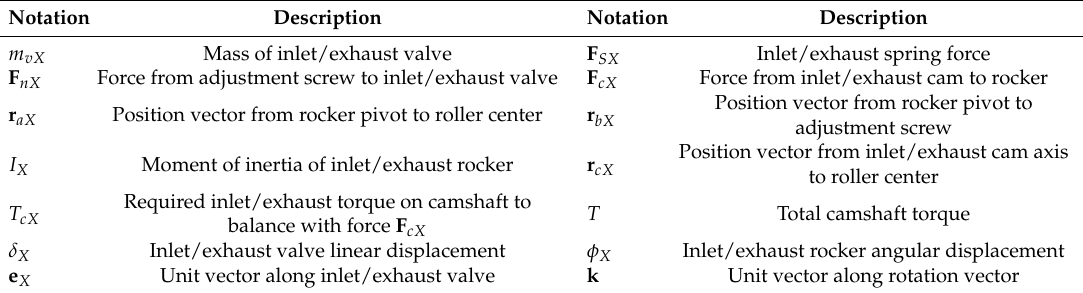
Figure 17. FBD of the proposed balancing mechanism [34]. The mechanism was able to cancel the resistive torque generated by the valve mechanism. Figure is reprinted with permission from publisher.